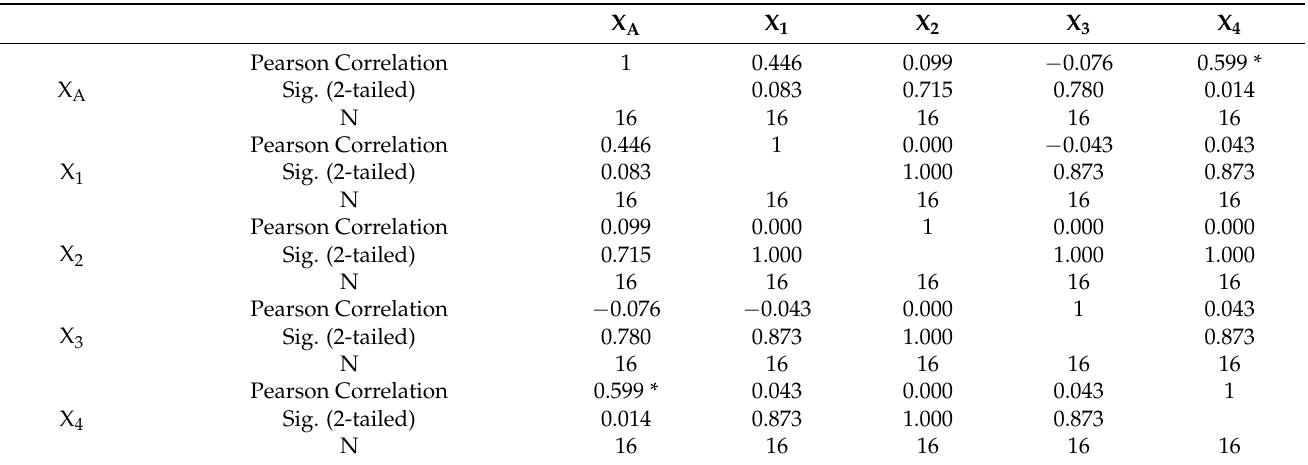
Table 2. Correlation analysis with four